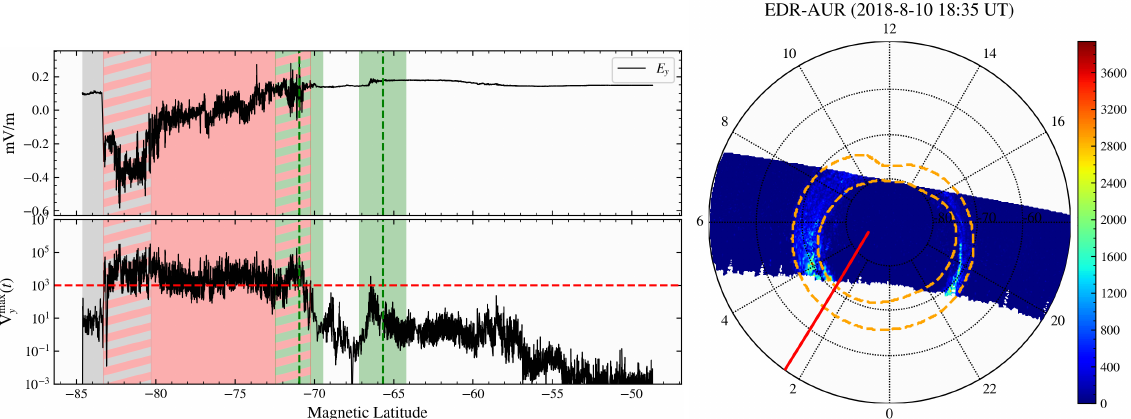
Figure 15. Same as Figure 8, except for orbit 2881. Positive detection of activity in the polar cap.